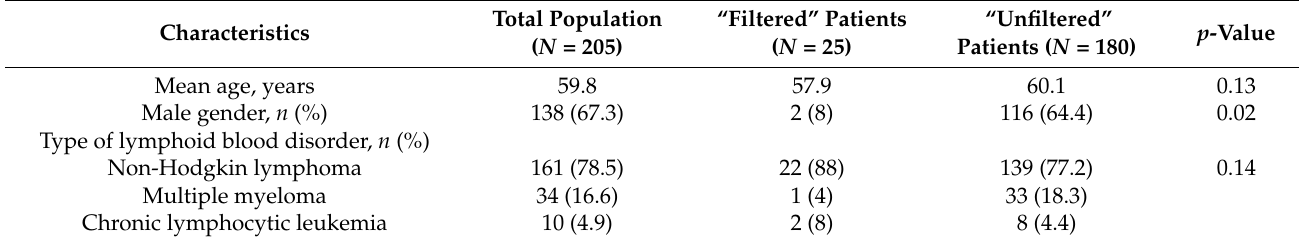
Table 2. Patient characteristics, RHELYPRO Study